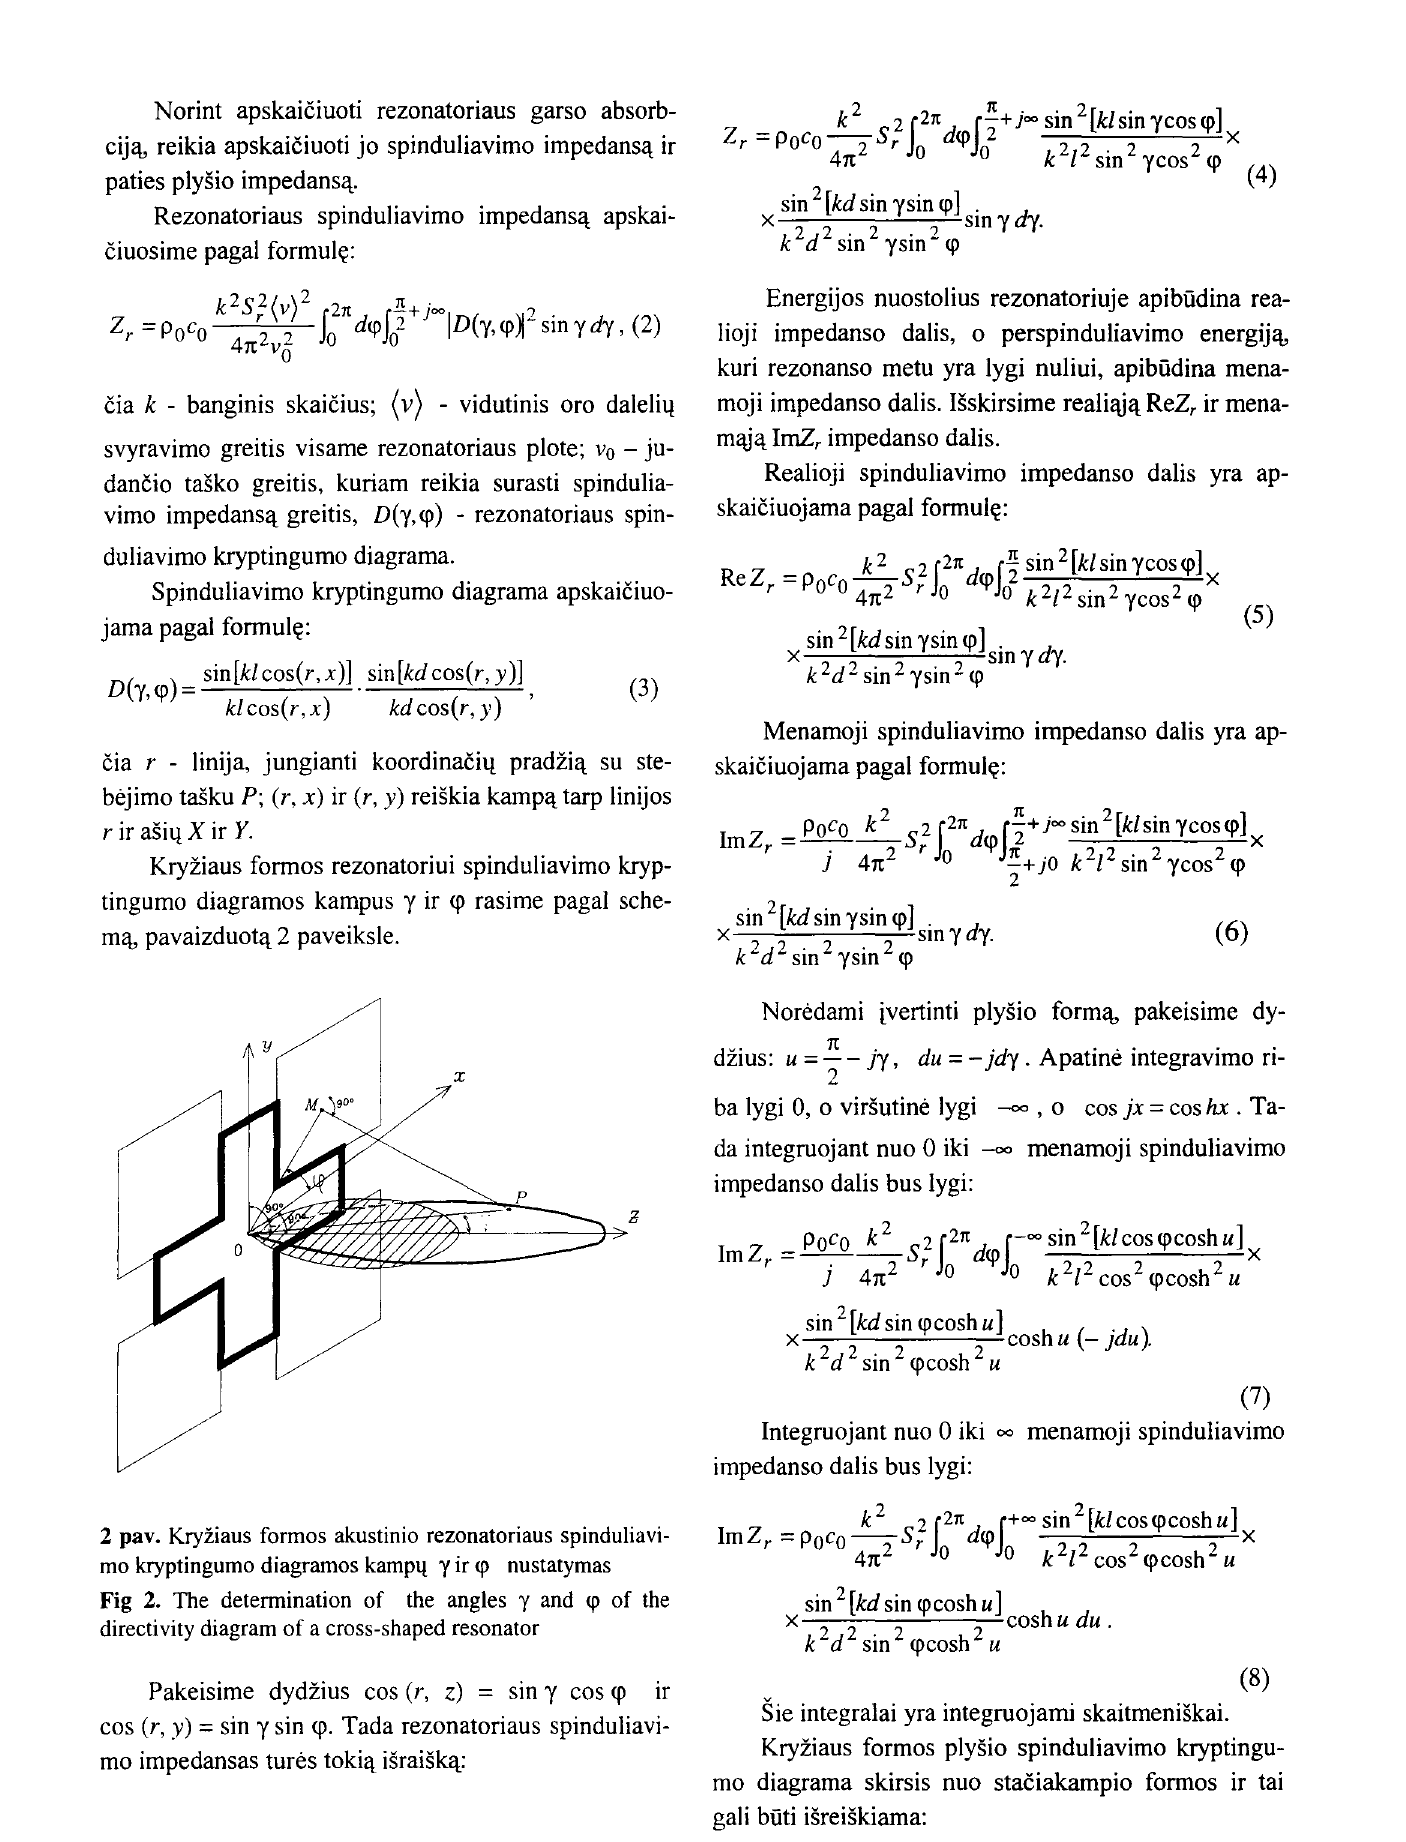
Fig 2. The determination of the angles y and q> of the directivity diagram of a cross-shaped resonator Pakeisime dydzius cos (r, z) = sin y cos <p ir cos (r, y) = sin y sin <p. Tada rezonatoriaus spinduliavi mo impedansas tures toki'l.